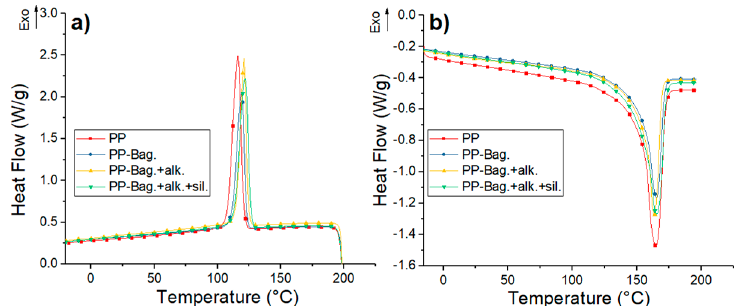
Figure 5. ( a ) Cooling and ( b ) second heating DSC curves for third processing cycle PP and PP-Bagasse biocomposites.